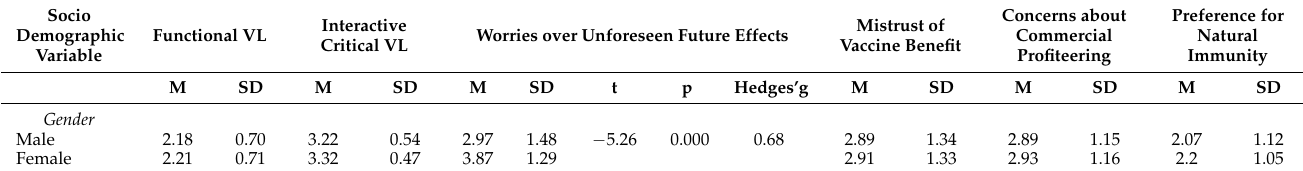
Table 4. Descriptive statistics of variables and gender differences.